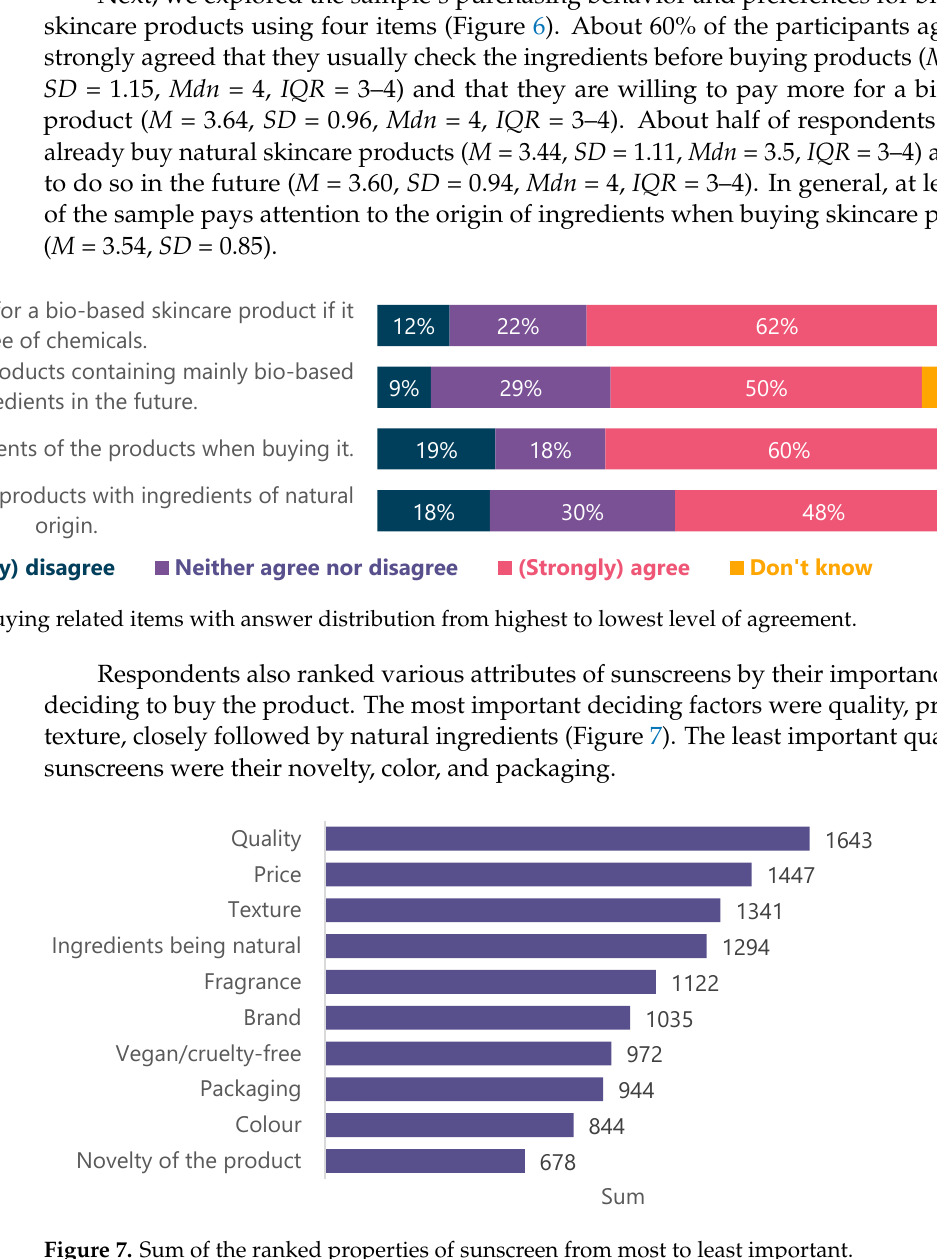
Figure 7. Sum of the ranked properties of sunscreen from most to least